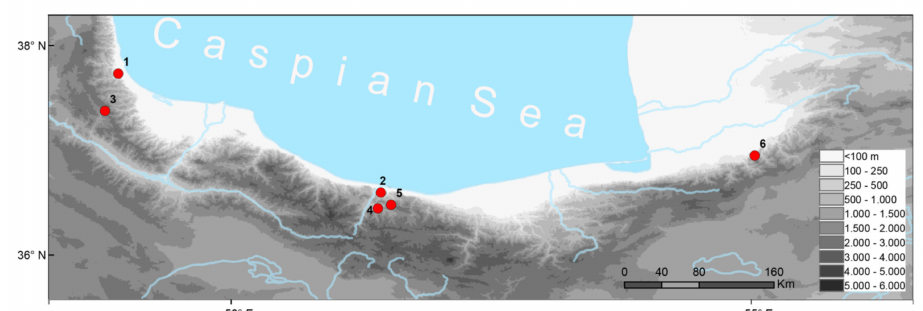
Figure 1. Map with sampling localities. 1 –Gilan Province, Talysh-mountains, 12 km S